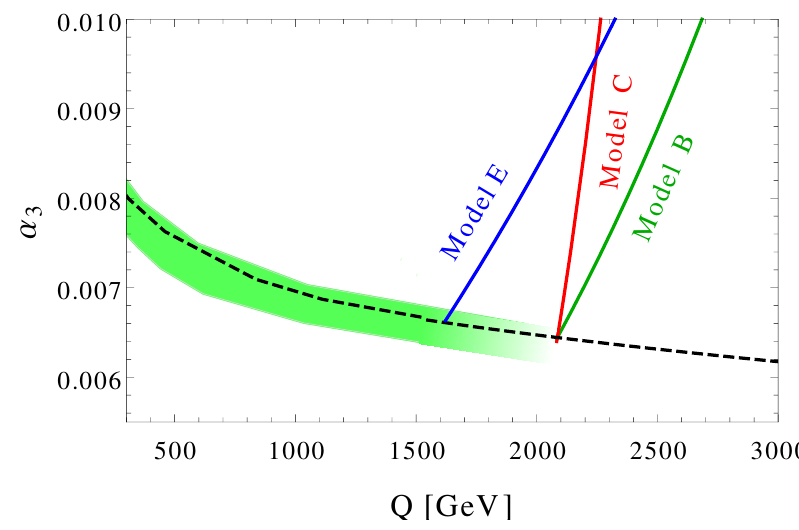
Figure 16 . SM running of the QCD coupling constant (black dashed line) and its uncertainty (green band) as determined by CMS [26]. Colored solid lines indicate the running of (cid:11) 3 in asymptotically safe benchmark scenarios B , C and E summarized in table 7 with a low matching scale around 1 : 5 to 2 TeV.